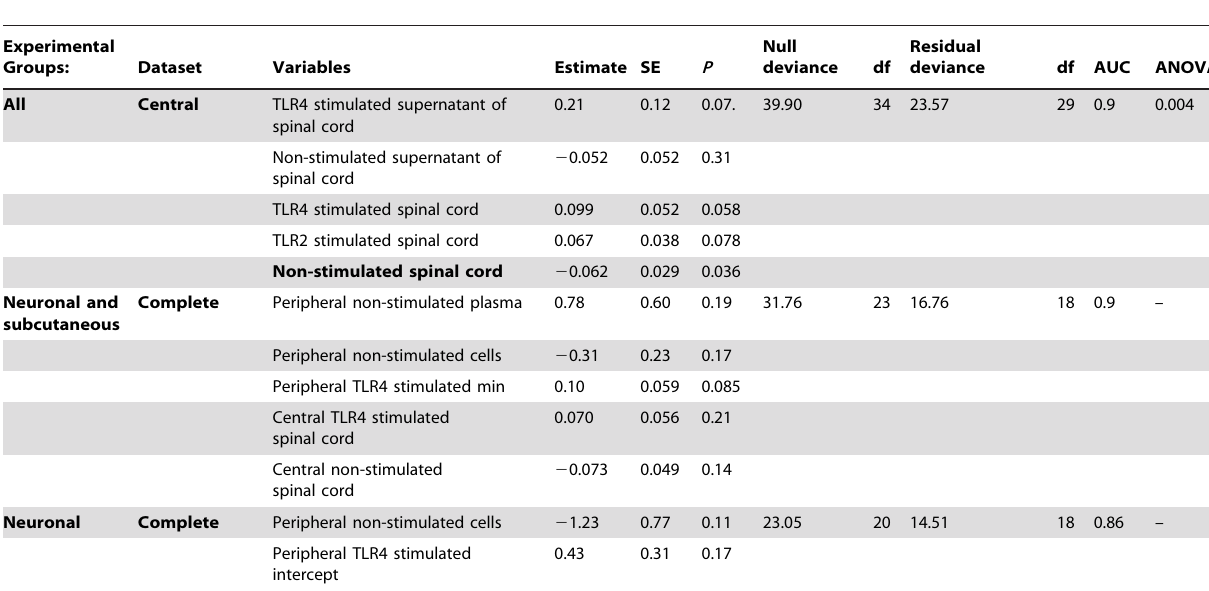
Table 4. Best-fit logistic regression model results for the prediction of pain for rats post